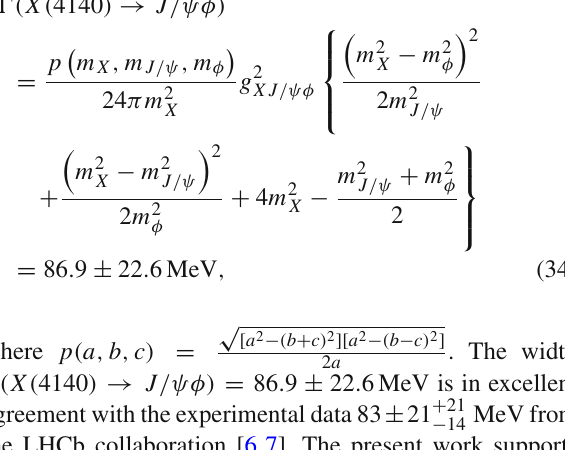
M X = 4146 . 5 MeV [6,7], λ X = 4 . 30 × 10 − 2 GeV 5 .